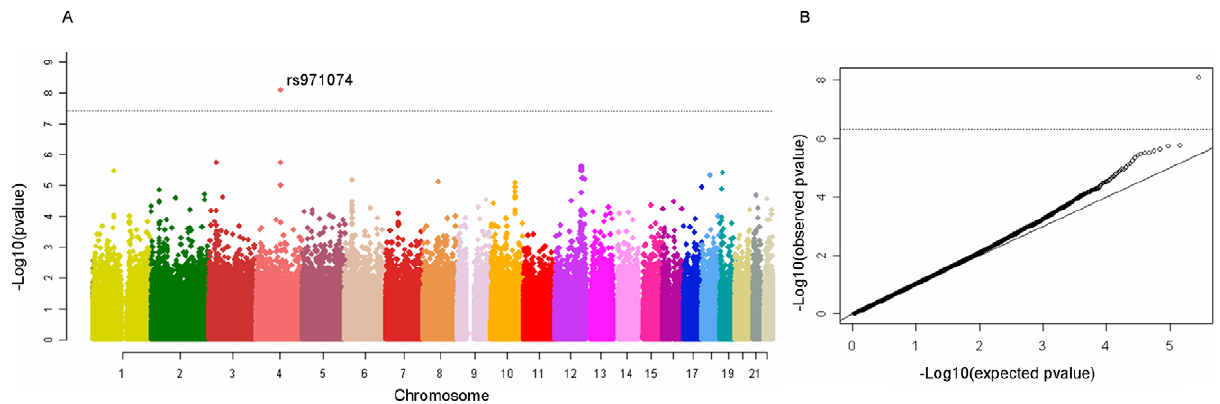
Figure 1. Manhattan plot of the ARCAGE and CE UADT cancer GWAS discovery phase. One clearly outlying marker, rs971074 is highly correlated with rs1573496, a SNP previously associated with UADT cancer risk. Right panel QQ plot for the UADT cancer GWAS.